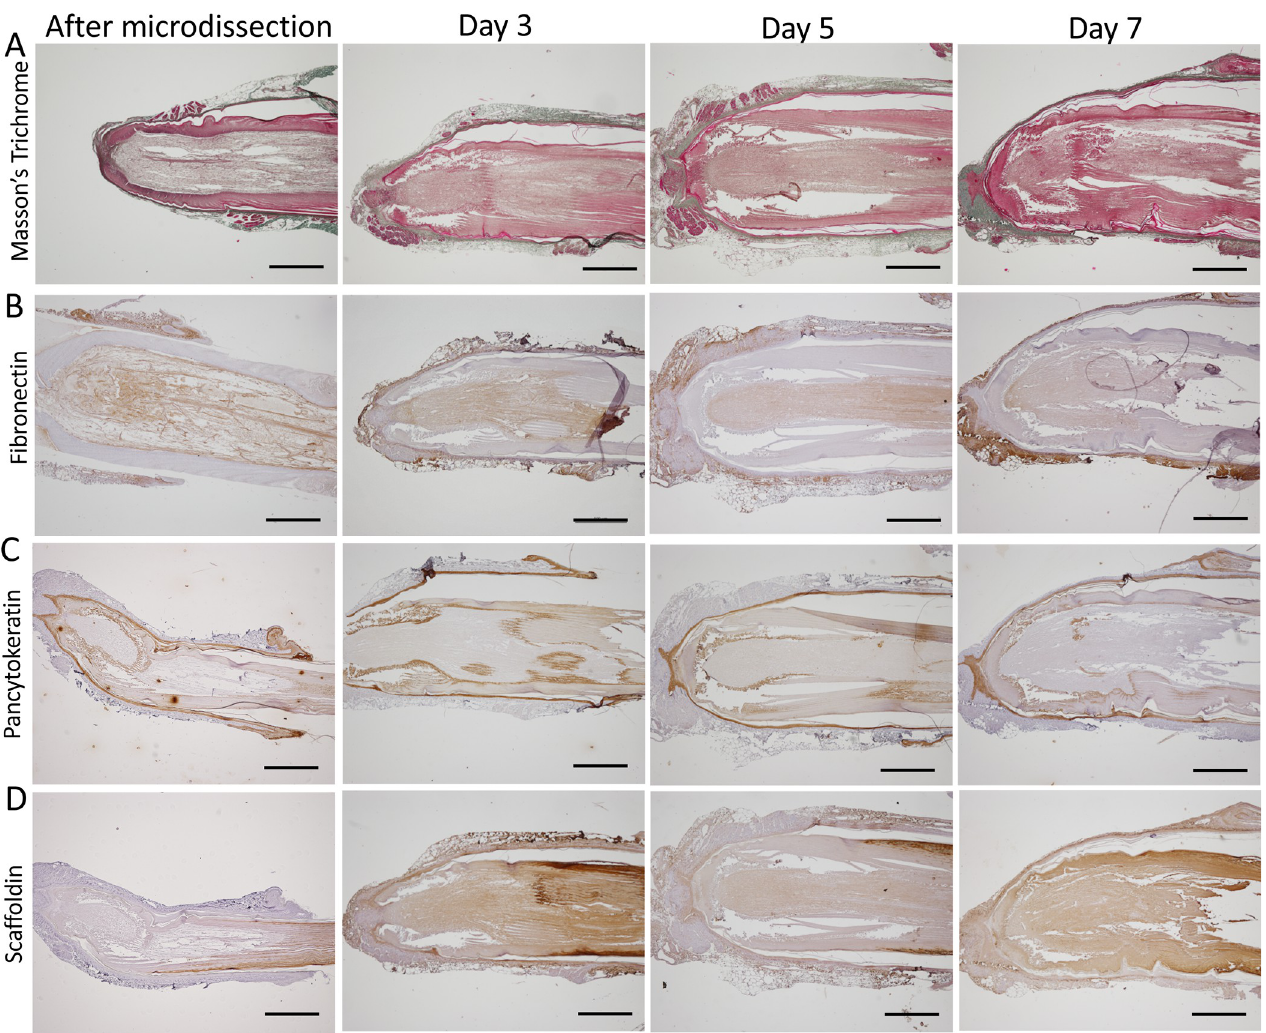
Fig 7. Expression and localization of avian markers by immunochemistry in FFs associated with growing feathers during cultivation in vitro . Formalin- fixed FFs embedded in paraffin were sectioned and stained with trichrome Masson (A), or labelled with the following antibodies: anti-fibronectin (B), anti-pan- cytokeratin (C), and anti-scaffoldin (D). Staining was performed after microdissection and at 3, 5 and 7 days of cultivation ex vivo . Bar represents 500 μ